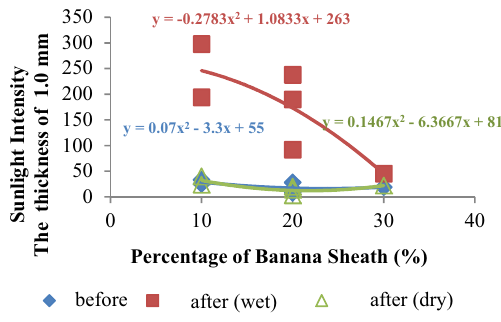
y = -0.362x2 + 25.47x - 316